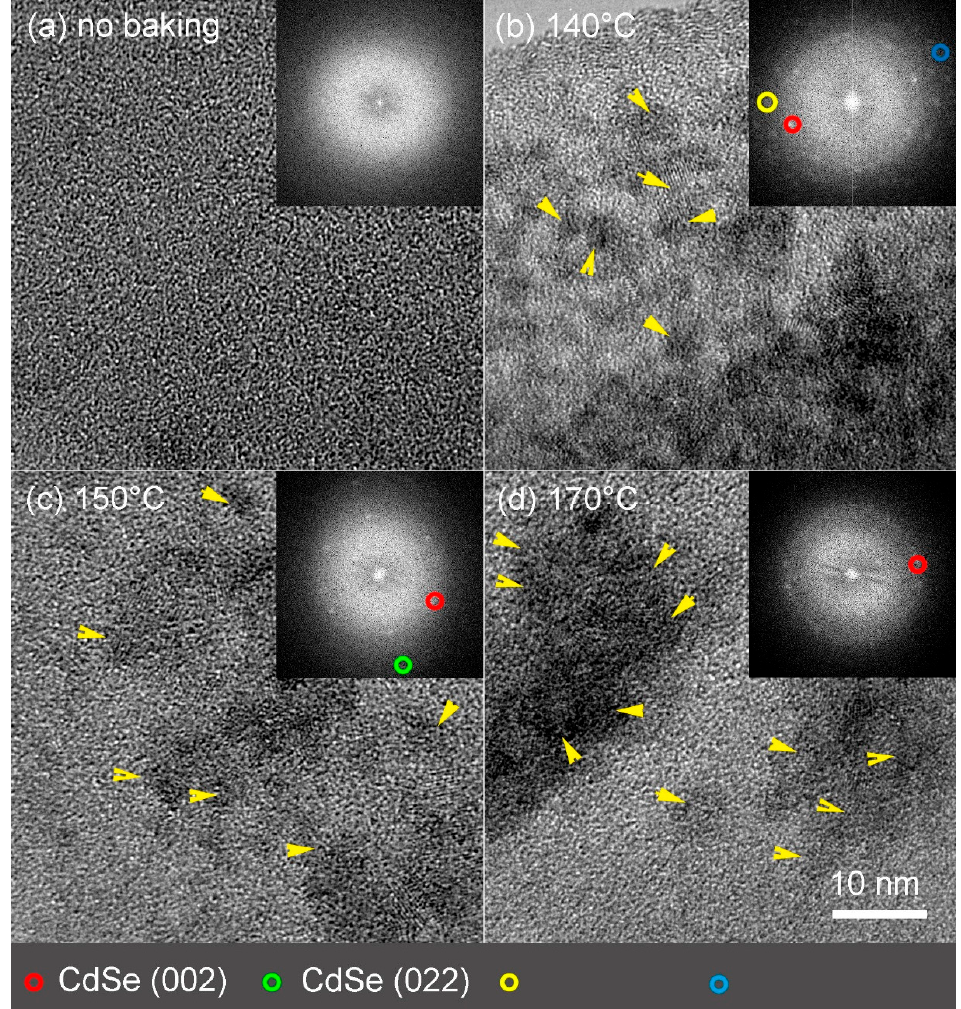
Figure 3. TEM characterization of Ppy9/CdDMASe precursor blends. The yellow arrows indicate the growing QDs. ( a ) High-resolution image of the film, before baking. ( b ) HRTEM of the film baked at 140 °C; (Inset) FFT of the particles highlighting the crystalline reflections (circles). The blue and yellow circles indicated unknown reflections. ( c ) HRTEM of the film baked at 150 °C; (Inset) FFT of the particles highlighting the cubic crystalline structure of the particles (circles). ( d ) HRTEM of the film baked at 170 °C; (Inset) FFT of the particles highlighting the cubic crystalline structure of the particles (circles).